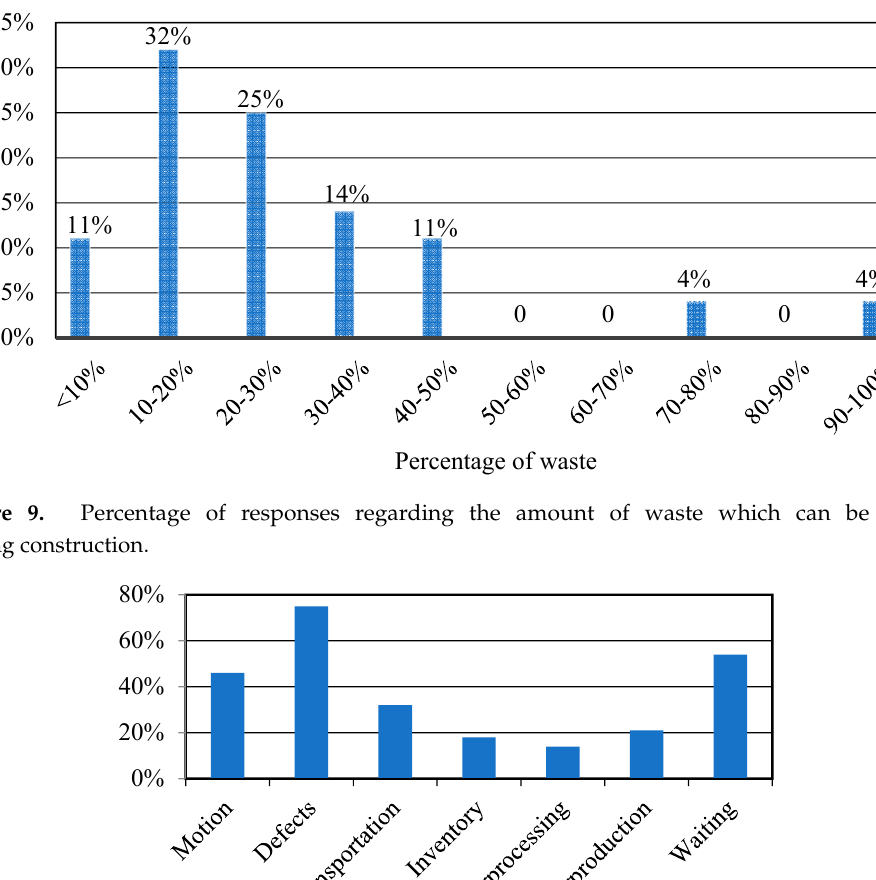
Figure 9. Percentage of responses regarding the amount of waste which can be found during construction.